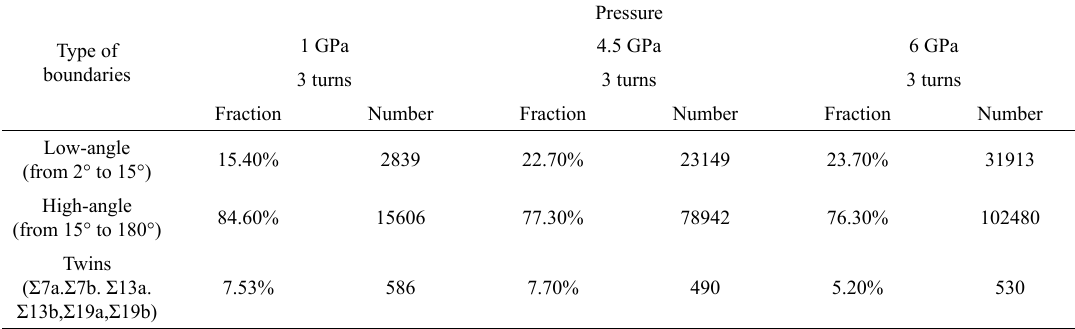
Table 2. Different types of grain boundaries after HPT